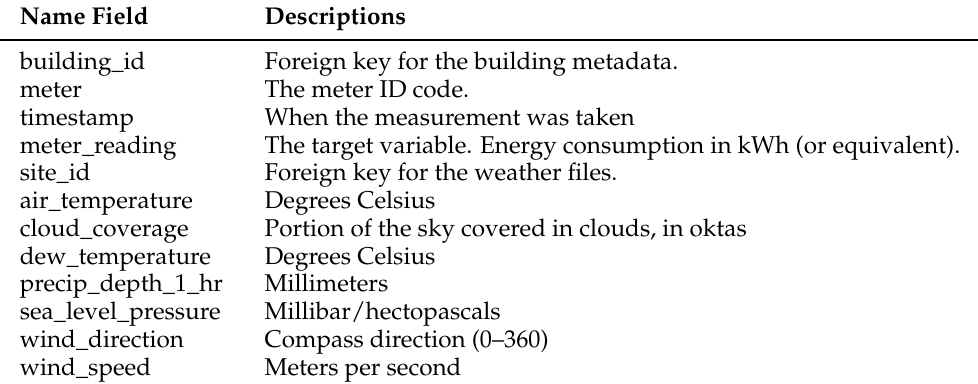
Table 2. Dataset